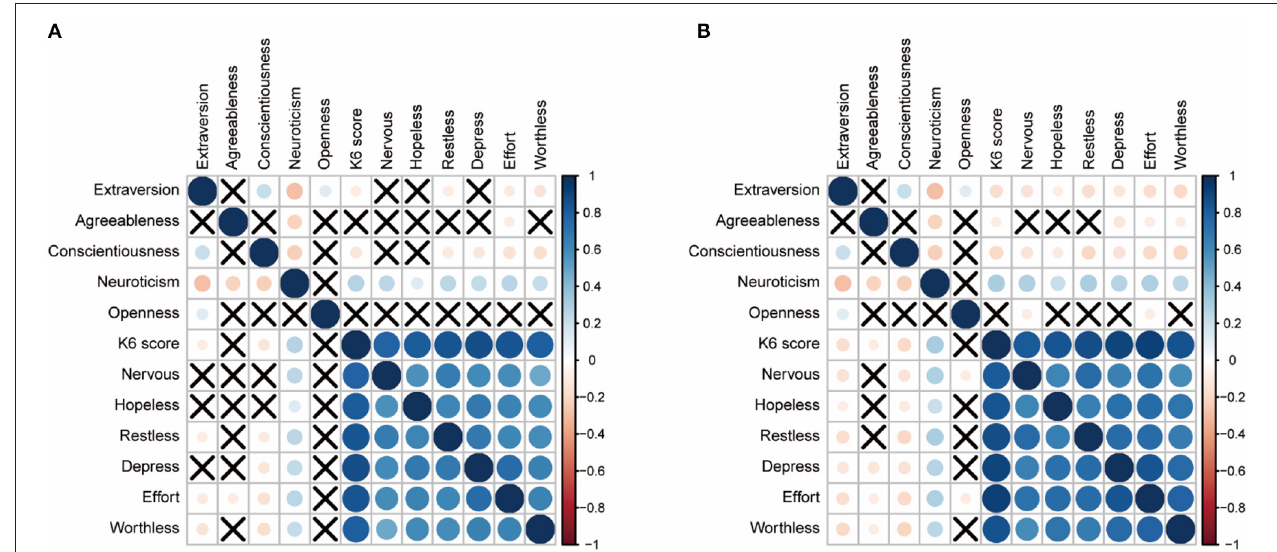
FIGURE 1 | Correlation results of the relationships among Big Five personality traits, K6 mean score, and all symptoms. Crosses in cells denote insignificant correlations. (A) Correlation matrix during college lockdown. (B) Correlation matrix after college lockdown.